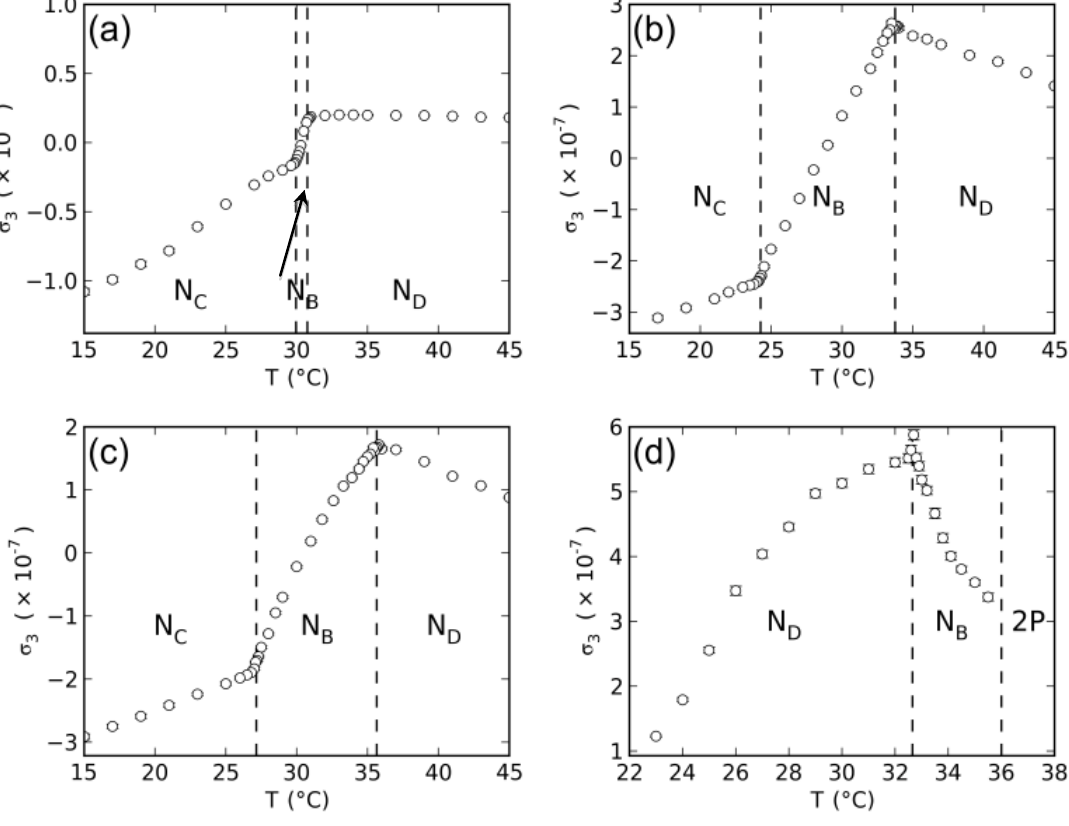
, of 3 SO /UndeOH/water; 2 4 SO 2 4